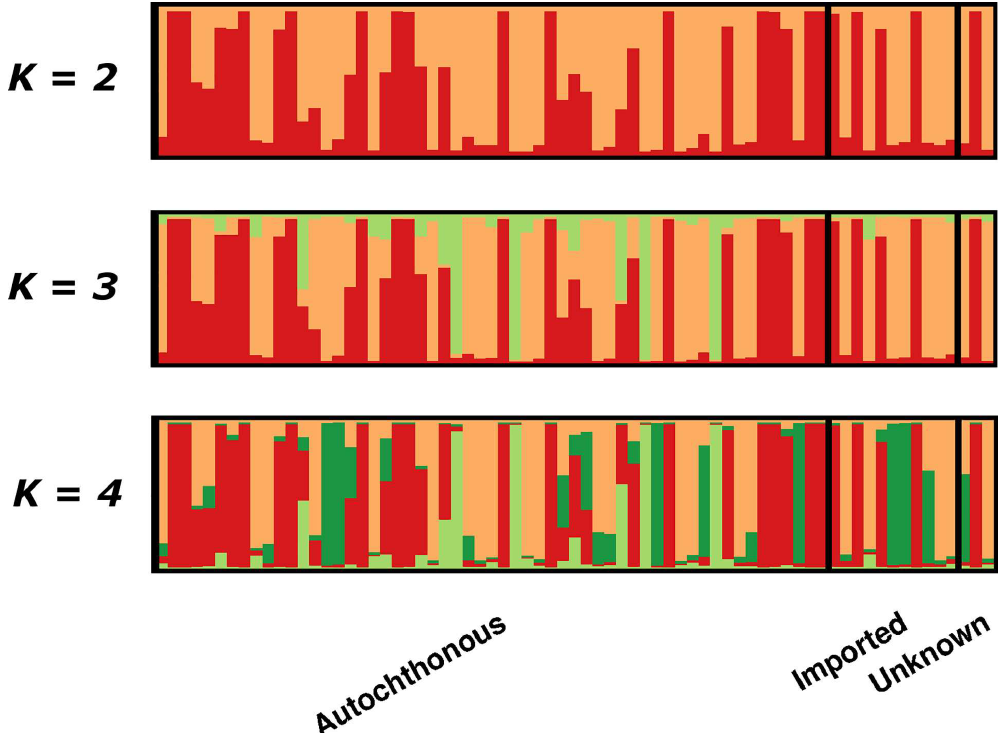
Fig 3. Population structure. Bar plots illustratingthe population structure at K = 2, K = 3 and K = 4. Each vertical bar representsan individualsample and each colourrepresents one of the K clusters (sub-populations) definedby STRUCTURE. For each sample, the predicted ancestry to each of the K sub-populations is representedby the colour-coded bars. K 1 = red, K 2 = orange, K 3 = light green and K 4 = dark green. Samplesare orderedby date of collection(oldest to newest) within each of the Autochthonous, Imported and Unknownsample